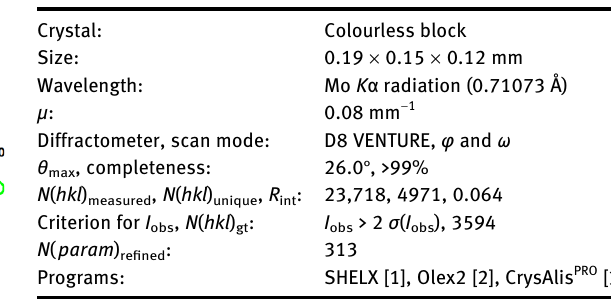
Table  : Data collection and handling.